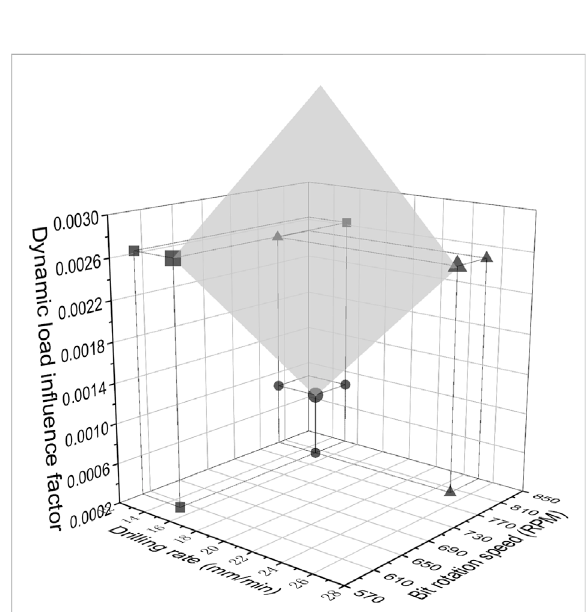
FIGURE 14 Relationshipbetweencon fi ningstressandtotalenergyunder different drilling parameter combinations.